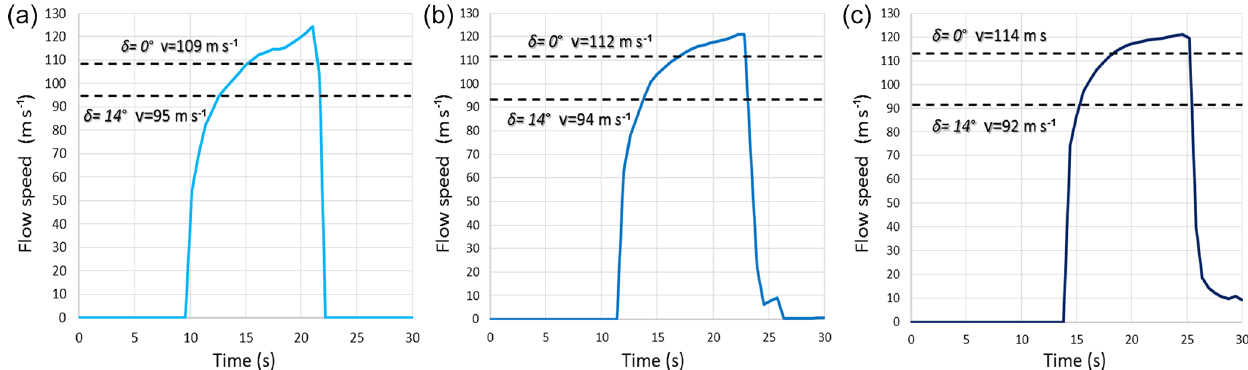
Figure 6. Impact speed distribution vs. time for the impacting fluid considering different slope angles of (a) 45 ◦ , (b) 40 ◦ , and (c) 35 ◦ . The lower and upper limits represent a reasonable speed interval for the centre of gravity of the deforming fluid when entering the waterbody (from Eq. 3.5 in Evers et al., 2019, with a dynamic bed friction angle δ of 0 and 14 ◦